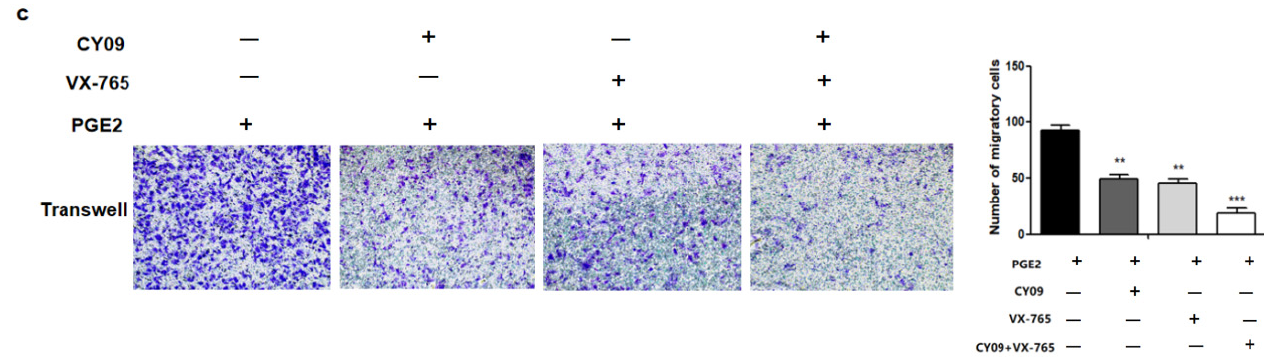
Figure 4. PEG2 promoted hEM15A migration through NLRP3/caspase-1 pyroptosis pathways. ( a ) In hEM15A, PGE2, co-cultured PGE2 + CY-09 (the inhibitor of NLRP3), co-cultured PGE2 + VX-765 (the inhibitor of caspase-1) and co-cultured PGE2 + CY-09 + VX-765, pyroptosis related proteins (NLRP3 and cleaved caspase-1) were detected by Western blot analysis. ( b ) In hEM15A, PGE2, co-cultured PGE2 + CY-09 (the inhibitor of NLRP3), co-cultured PGE2 + VX-765 (the inhibitor of caspase-1) and co-cultured PGE2 + CY-09+VX-765, the level of IL-1 β and IL-18 in cell culture medium were detected by ELISA. ( c ) In hEM15A, PGE2, co-cultured PGE2 + CY-09 (the inhibitor of NLRP3), co-cultured PGE2 + VX-765 (the inhibitor of caspase-1) and co-cultured PGE2 + CY-09 + VX-765 were evaluated by Transwell migration assay in different groups.** p < 0.05, *** p < 0.001 by one-way ANOVA.